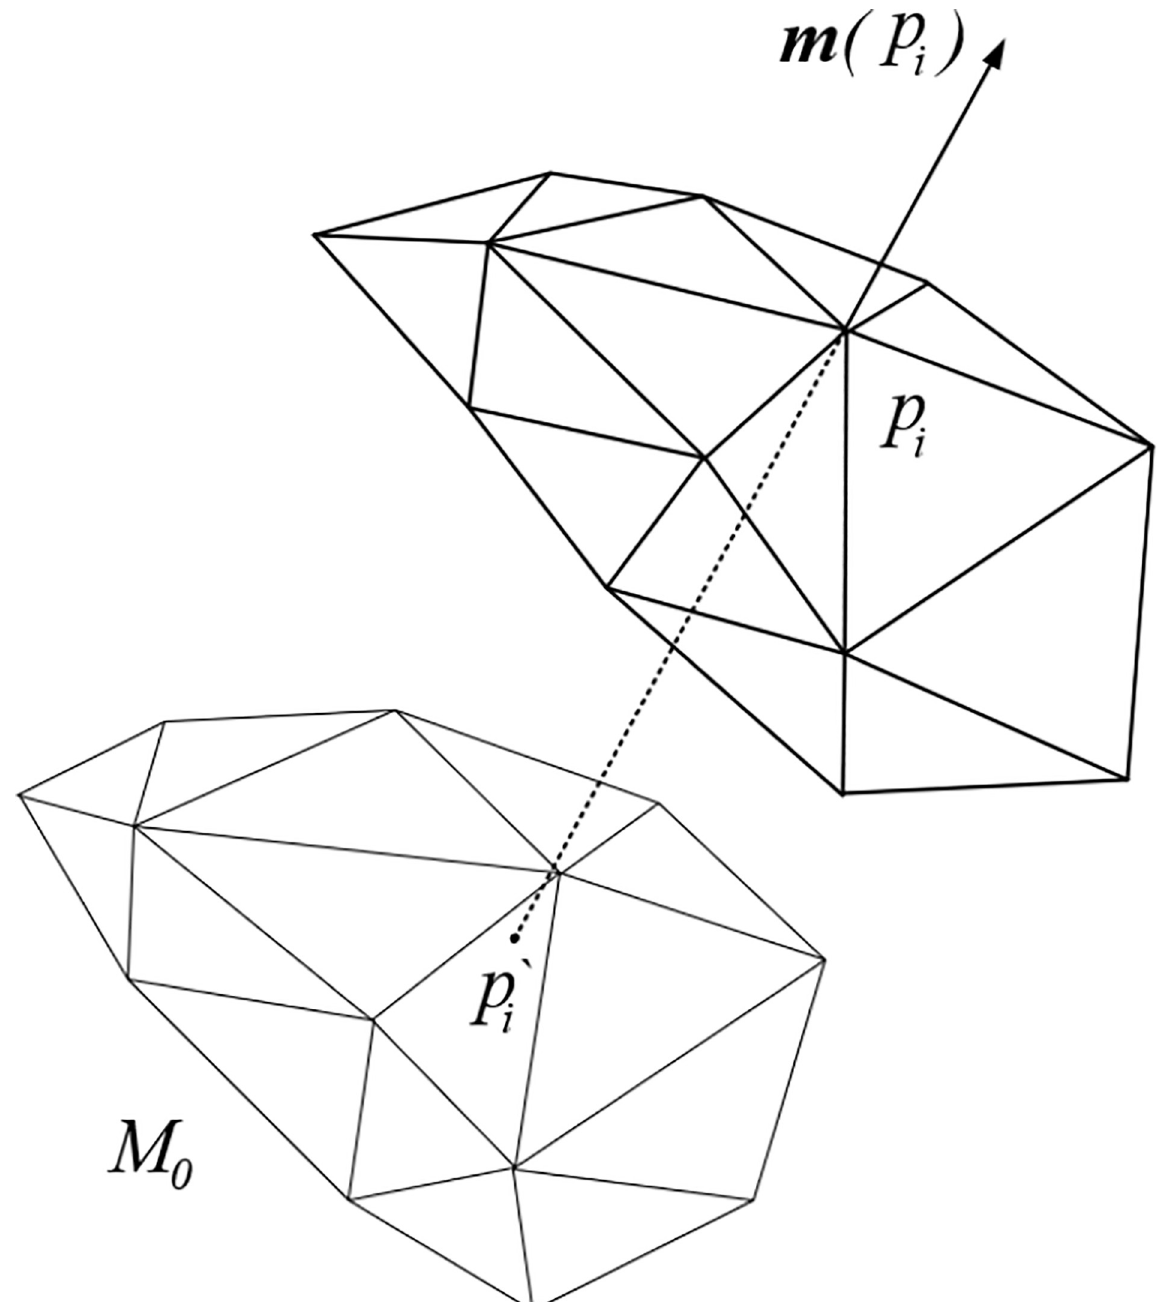
Fig 7. Projection operation of surface mesh